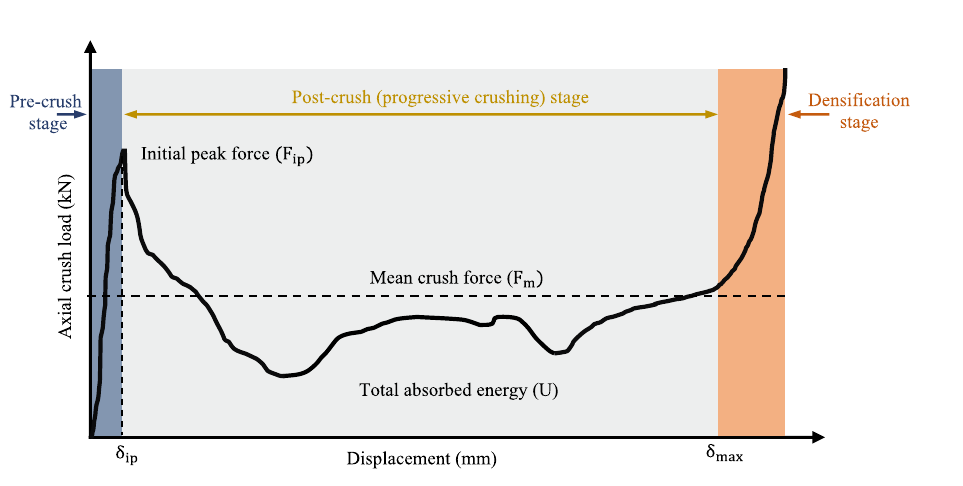
Figure 4. Typical load–displacement curve of composite energy absorption